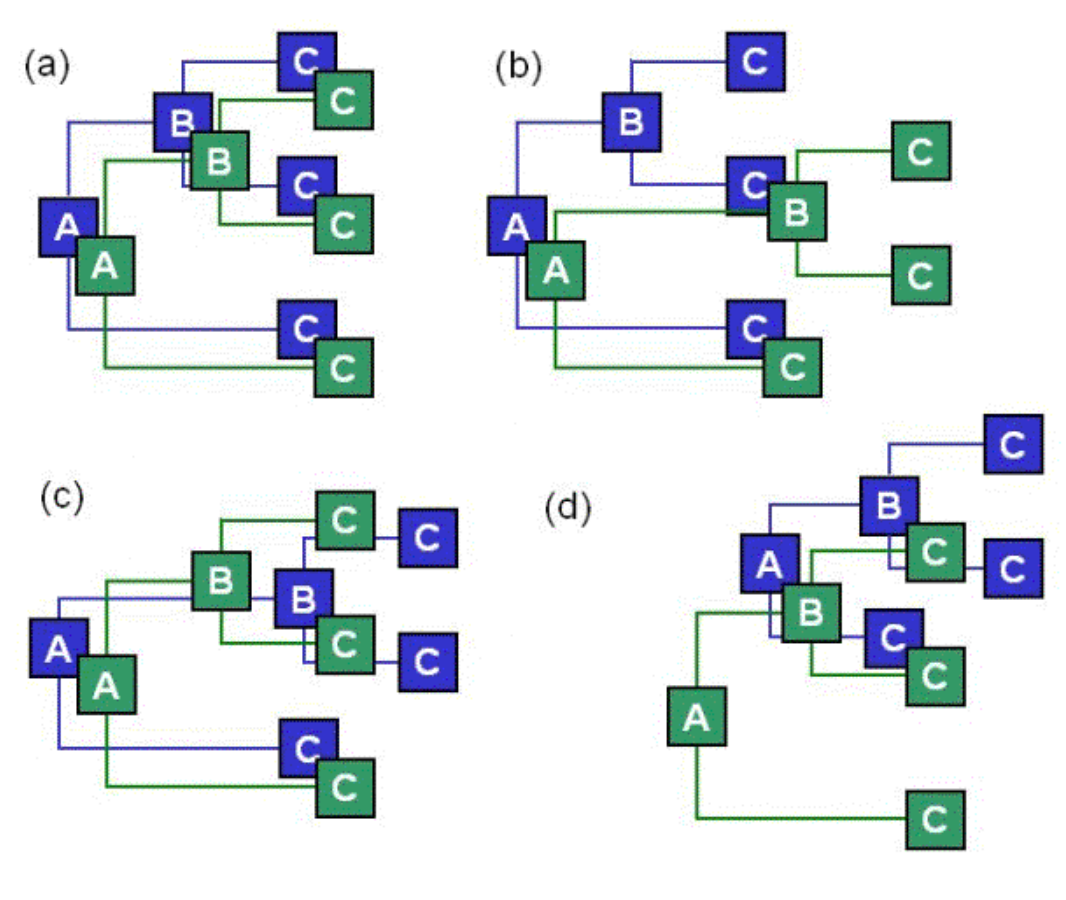
Fig. 4 . Examples of how hierarchies may be aligned or misaligned in a natural resource management situation. Ecological processes (green boxes) are managed by people (blue boxes). Overlapping boxes indicate interactions between units, and the labels A, B, and C denote matching levels between hierarchies. (a) In an ideal situation, ecological processes will be managed by people who have the mandate and the power to act at the same scale as the process. (b) Scale mismatches may result in upper-level managers who have nothing to do but micromanage their juniors, while lower-level managers are confronted with ecological problems that they lack the resources to deal with (C-B mismatch). (c) Another kind of mismatch results in a lack of management at some key scales (unmanaged B) and the involvement of higher-level managers in lower-level resource management (B-C mismatch), leaving junior managers with little power to effect change (dangling C). (d) In a global or international context, a common scale mismatch occurs when no institution exists to deal with the broad-scale environmental problem (unmanaged A). Note that in many examples, scale mismatches are not necessarily